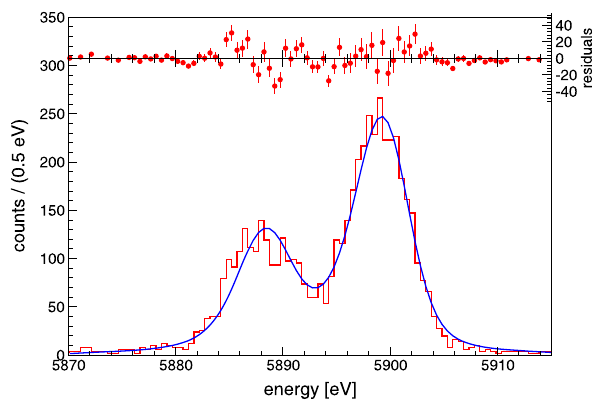
Fig. 5 SeparationoftheK α 1 andK α 2 oftheMn,obtainedwithdetector ( a ). The FWHM resolution achieved in this energy range is (4.5 ± 0.1) eV